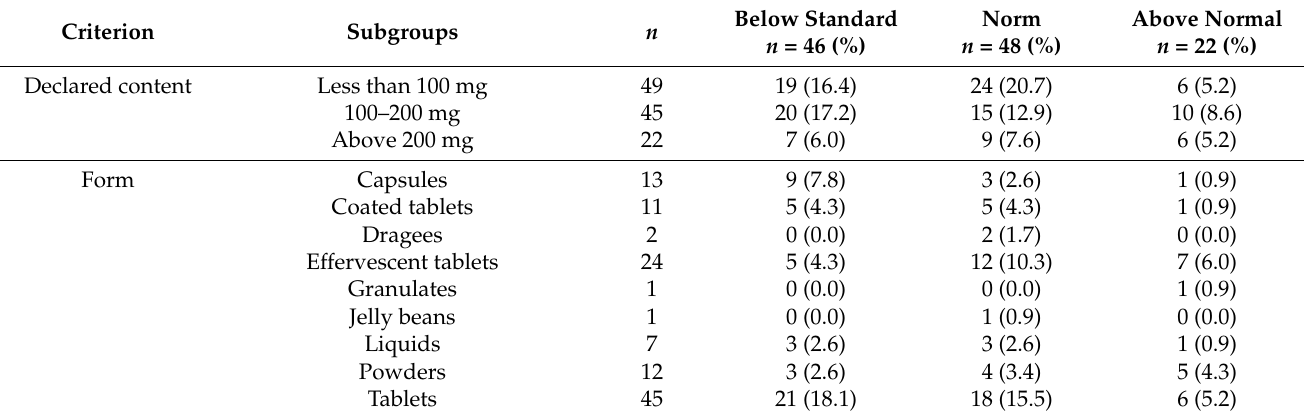
Table 6. Relationship between factors and percentage of food supplements with normal, below and above normal mag- nesium levels ( p > 0.05).